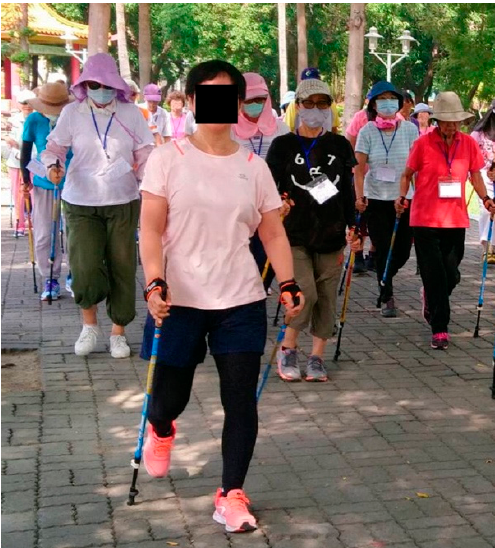
Figure 2. Nordic